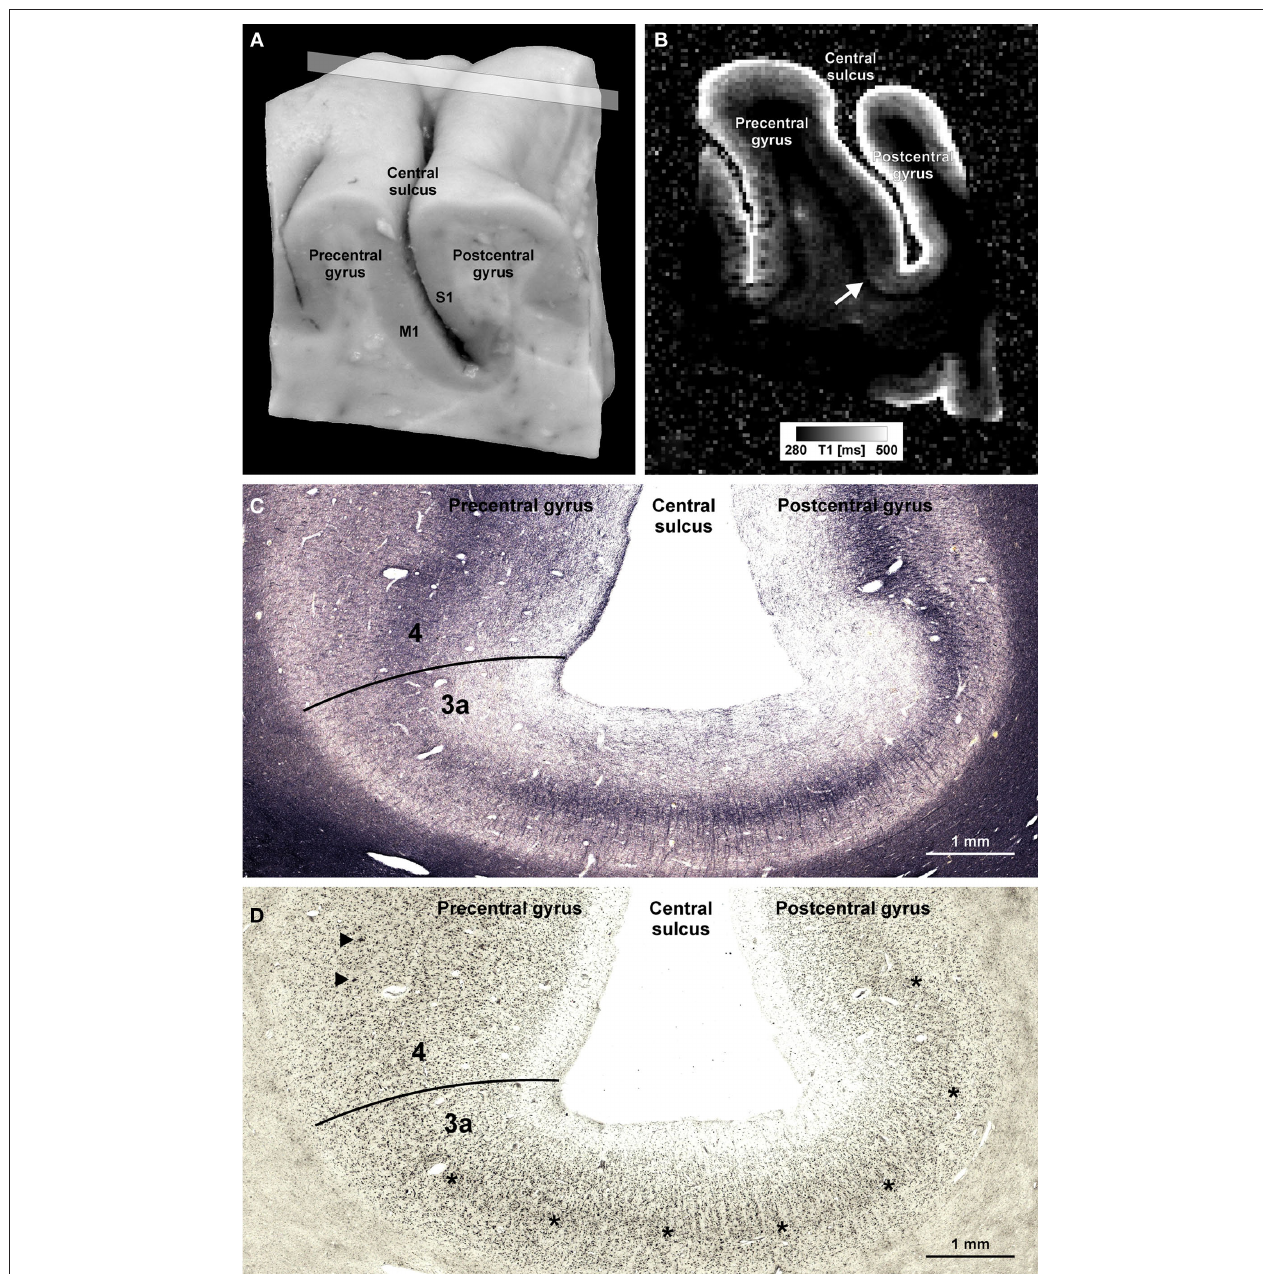
myelo- and cytoarchitectonic pattern [cf. (C,D) ]. (C,D) Frozen sections (30 μm) from a corresponding position of the same block stained for myelin basic protein [rat monoclonal antibody, avidin–biotin–peroxidase complex (ABC) method, chromogen: DAB and ammonium nickel(II) sulfate (C) ] and cell bodies [according to Merker, 1983; (D) ]. Micrographs show the fundus of the central sulcus [same orientation as in (A,B) ]. The drop in T1 values at the base of the precentral gyrus coincides with an increase in myelin basic protein immunostaining [line in (C) ]. In an accompanying section stained for cell bodies, this position is characterized by an increase in gray matter thickness, a disappearing inner granular layer (asterisks), and emerging giant pyramidal (Betz) cells (arrowheads). This transition [lines in (C,D) ] corresponds to the border between area 3a (somatosensory cortex) and area 4 (primary motor cortex; Geyer et al.,